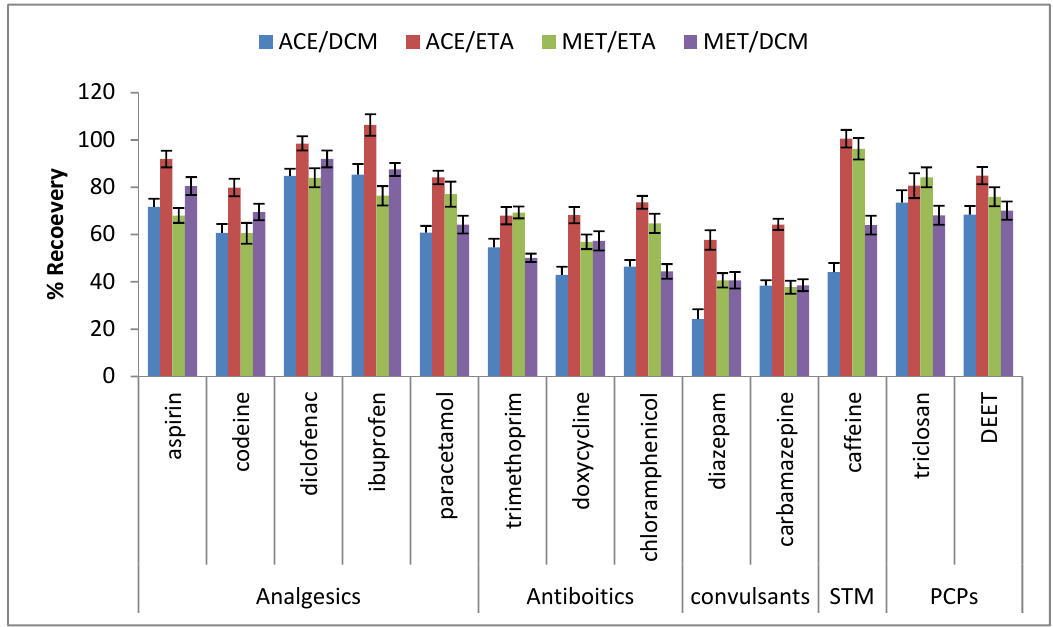
Figure 2. Solvents used for extraction in soil sample and % recovery.